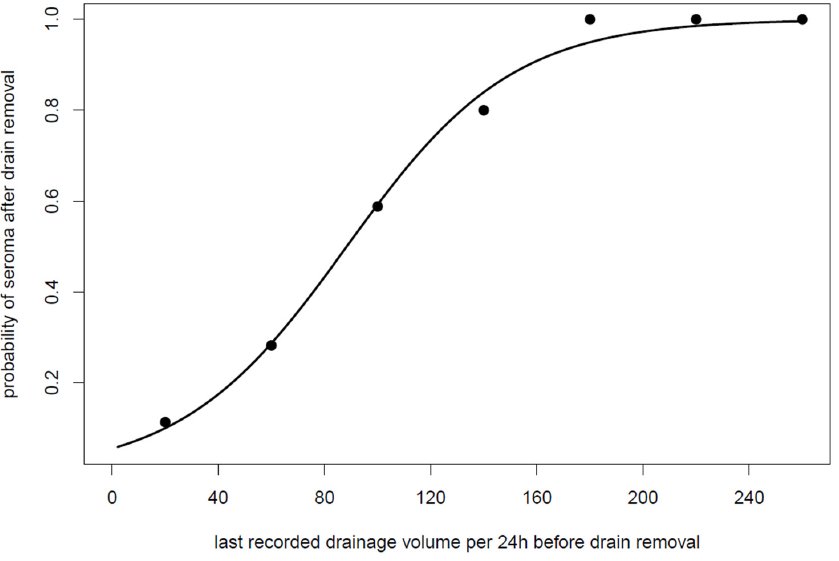
Figure 2. The probability of seroma puncture depending on the drainage flow rates in the last 24 h before removal of the drainage with empirical proportions observed in drainage volume intervals of 40 mL (shown as big dots). The logistic regression shows that a high drainage volume before removal has a high probability of developing seroma needing evacuation in the future.